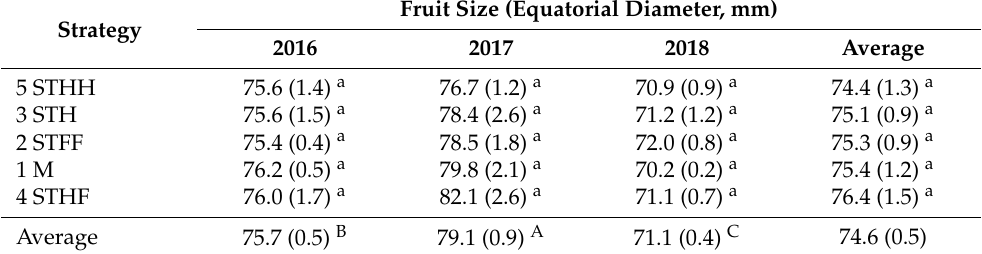
Table 8. Fruit size (equatorial diameter, mm) for each strategy and year, ordered by the increasing 3-year average size 1